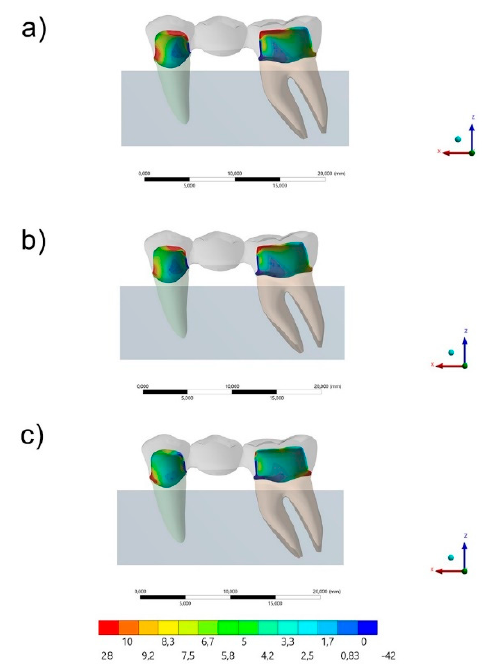
Figure 2. Finite element model showing ( a ) fixed support, ( b ) meshing division and ( c ) occlusal loading.